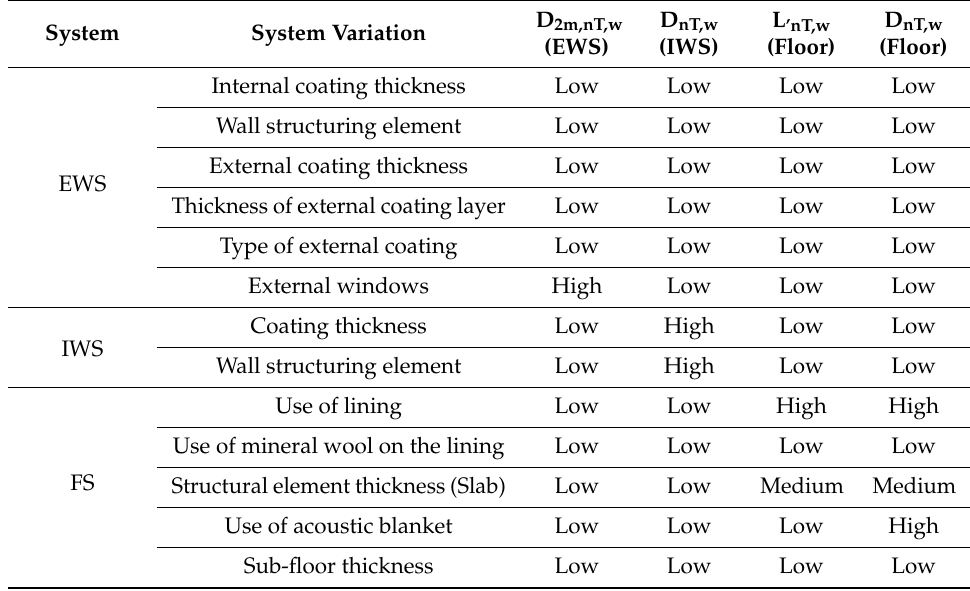
Table 23. Level of influence of the variations adopted in the acoustic performance in relation to the reference model.